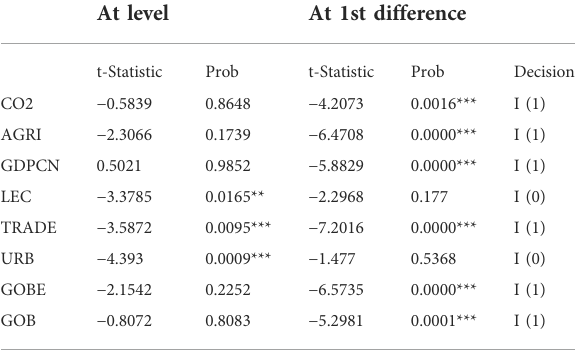
TABLE 2 Phillip Perran Unit root test.